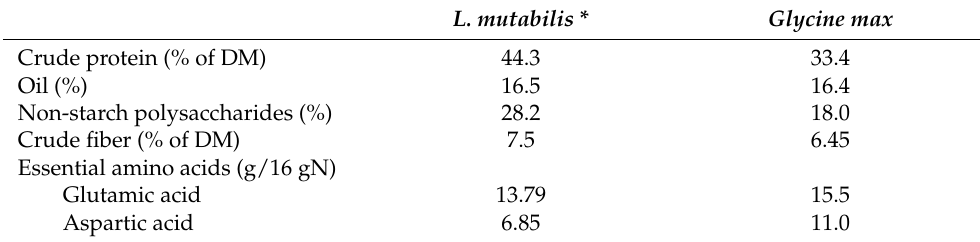
Table 1. Chemical composition of Andean lupin compared with